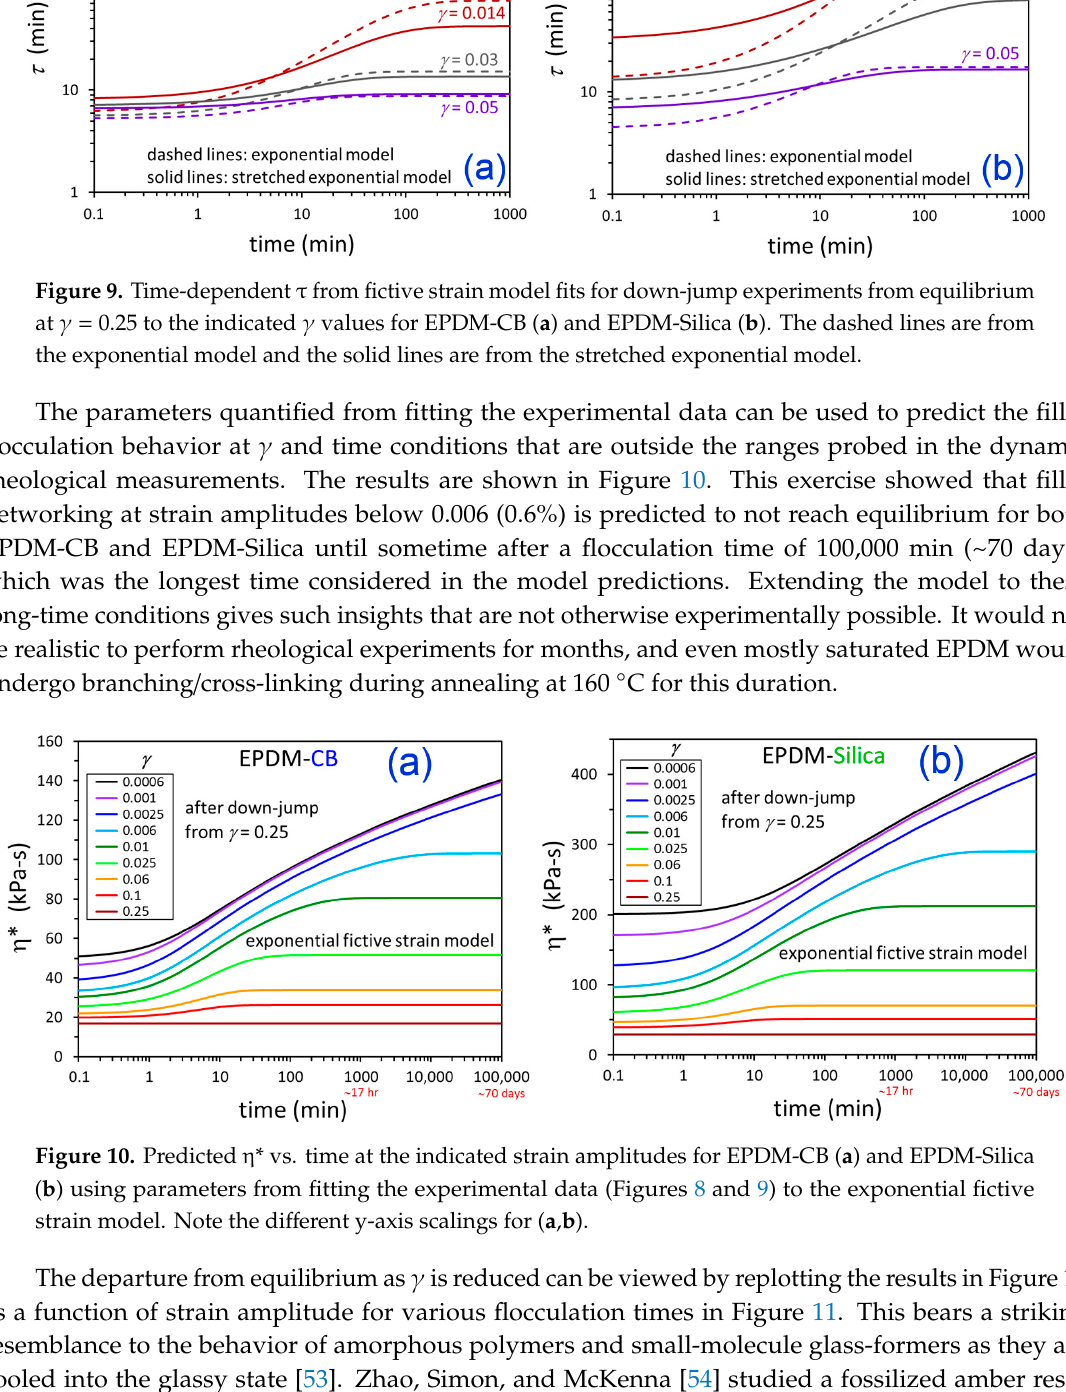
strain model. Note the different y-axis scalings for ( a , b ).